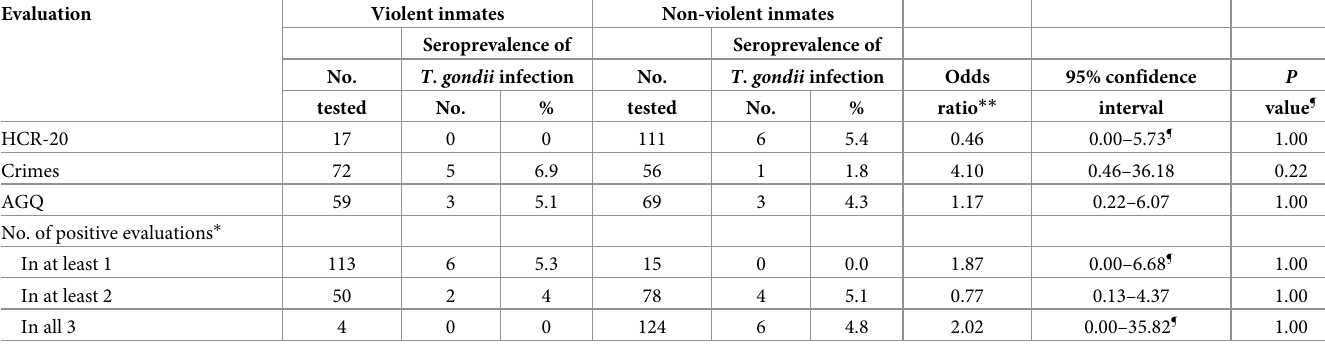
Table 2. Association between T . gondii seropositivity rates and violence groups.